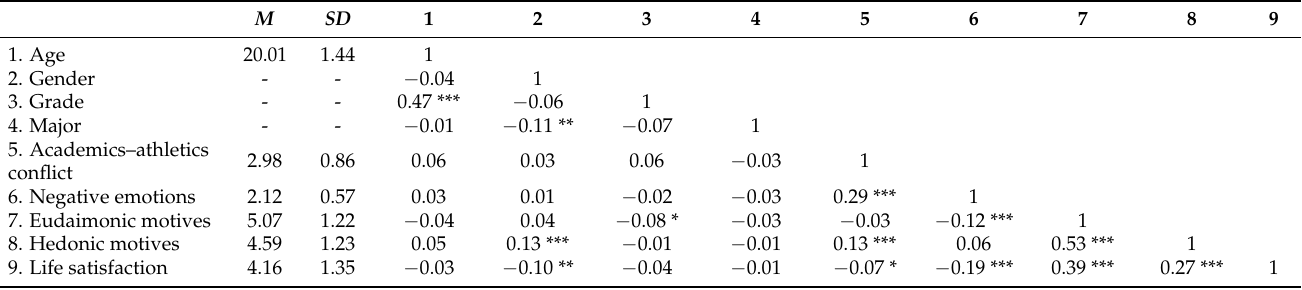
Table 1. Descriptive statistics and correlation matrix of all variables ( n =